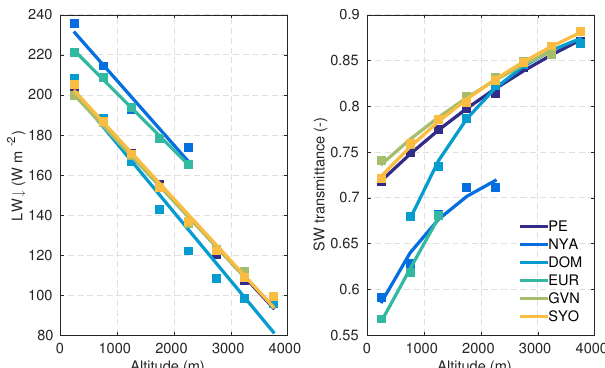
Figure 6. Relationship between altitude and downwelling radia- tive fluxes: LW ↓ radiation (left) and SW ↓ transmittance (right), for the six AWS locations, based on all available satellite-retrieved LW ↓ fluxes and SW ↓ transmittances between 2007 and 2010 within 1000km of each of the six AWS locations according to surface alti- tude of the satellite